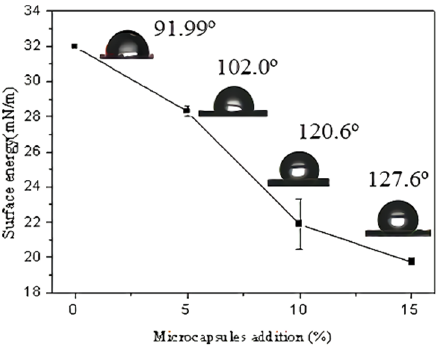
Figure 10. Water contact angles and surface energies of the coatings.